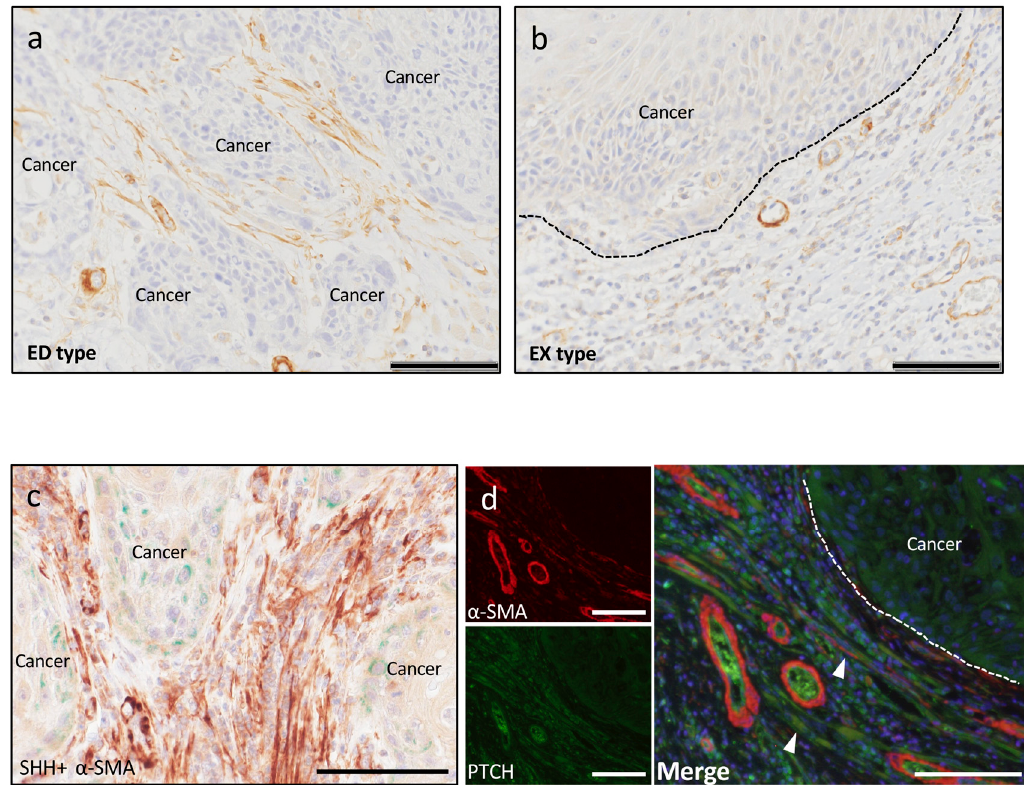
Figure 5. IHC, double IHC and immunofluorescence of α -smooth muscle actin ( α -SMA). ( a ) IHC staining for α -SMA in ED type. The abundant α -SMA-positive spindle-shaped cells were observed around the cancer nests. Scale bar: 100 µ m. ( b ) IHC staining for α -SMA in EX type. Almost all spindle-shaped α -SMA-positive cells were not observed. Scale bar: 100 µ m. ( c ) Double IHC staining for α -SMA (green)-CD11b (brown) in ED type. There was a large concentration of α -SMA at the site close to the cancer parenchyma where SHH expression was strong. Scale bar: 100 µ m. ( d ) Double- fluorescent IHC in ED type. Double-fluorescent IHC staining of α -SMA and PTCH demonstrated that the abundant α -SMA-positive cells merged (arrowheads) with PTCH partially in ED type. Scale bar: 100 μ m.